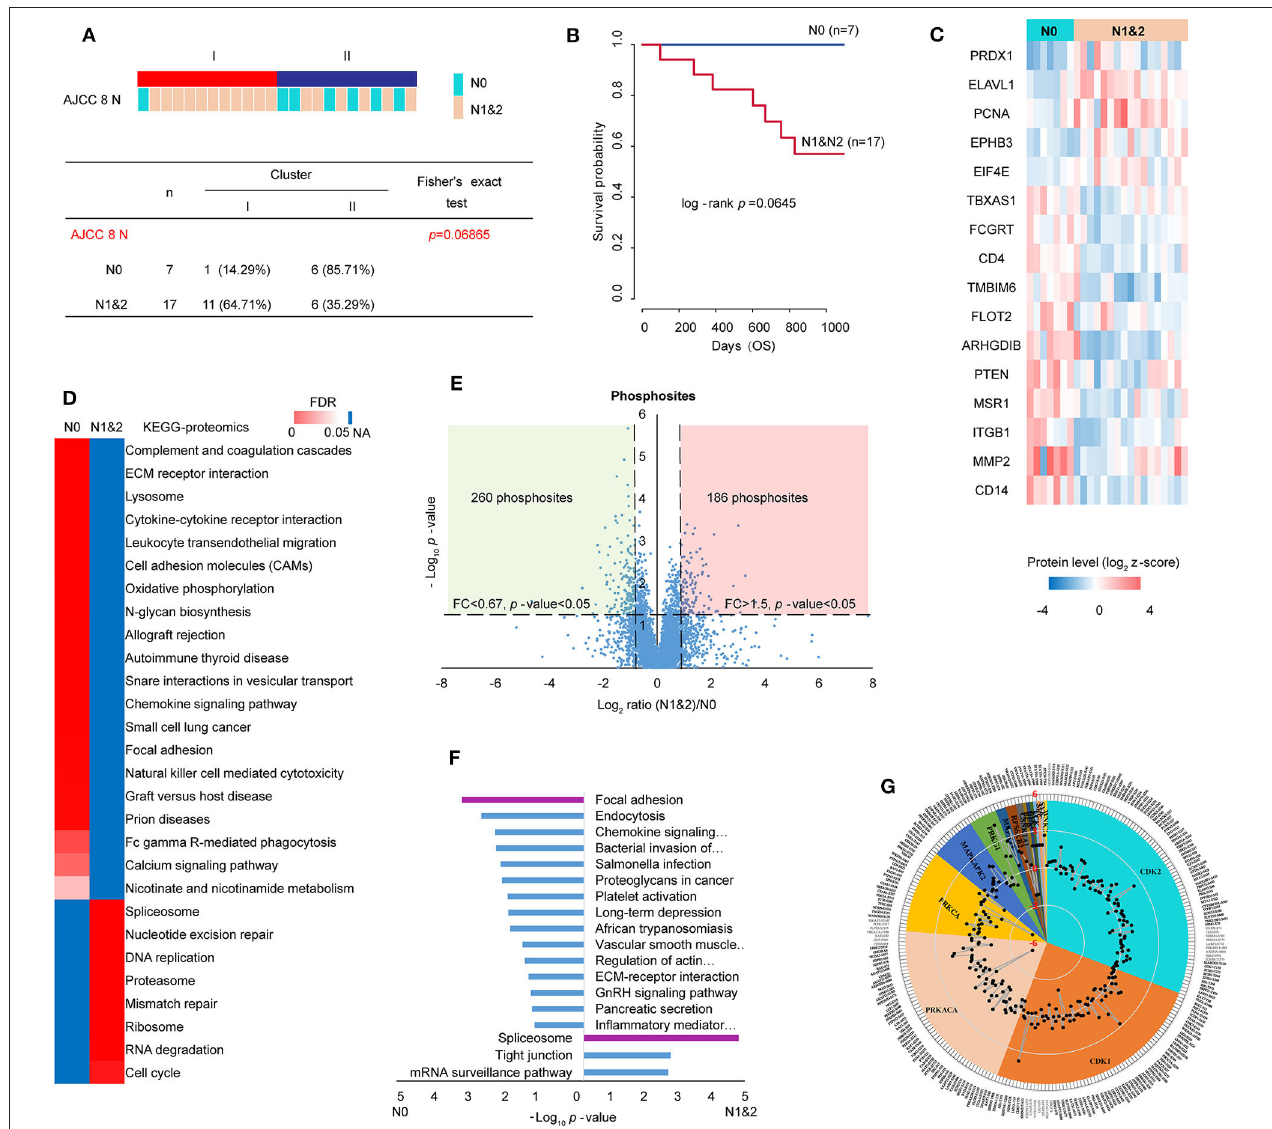
FIGURE 4 | Analysis of lymph node metastasis (LNM). (A) Relationship of cluster with LNM. Fisher’s exact test was adopted for the analysis. (B) The prognosis of patients with or without LNM within 3-year follow-up. (C) 16 differential metastasis-related proteins based on total 355 proteins which were associated with lung cancer metastasis from HCMDB database (fold change > 1.5, p -value < 0.05). (D) GSEA analysis of proteomic data with and without LNM (tumor samples, n = 24): N0 (without LNM, n = 7) and N1&2 (with LNM, n = 17). The heatmap showed the enriched KEGG pathways from MSigDB. The color in heatmap was according to FDR, and the darkest blue represents N/A. (E) Scatter plot depicting the fold change in phosphosites comparing N1&2 with N0. Log 2 fold changes were shown on the x-axis and –log 10 p -values are shown on the y-axis. The vertical dashed lines indicated fold change > 1.5 and the horizontal dashed line indicated p -value < 0.05 ( t -test). (F) DAVID analysis of phosphoproteomic data between N1&2 and N0. The bar chart showed the enriched KEGG pathways of the regulated phosphoproteins between N1&2 and N0 (fold change > 1.5, p -value < 0.05). The highlighted pathways were consistent with those enriched in the protein level. (G) Circular plot represented potential kinases and phosphosites retrieved from the PhosphoSitePlus database. The phosphosites were differentially expressed between N1&2 and N0 with a cutoff of 1.5-fold change. Different colors correspond to various kinases that were predicted as upstream regulators of the phosphosites ( p -value < 0.05). The outer circle shows the sites. The radar map shows the fold changes of the sites.